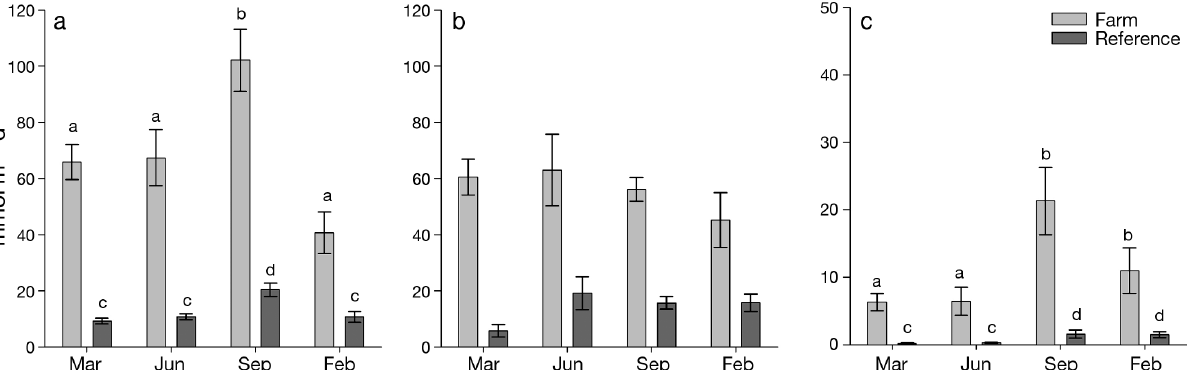
Fig. 3. Average (a) sediment oxygen consumption, and effluxes of (b) total CO 2 and (c) NH 4+ at the farming and reference loca- tion at 3 different time points over the production cycle. Superscripts denote significant differences across seasons and between sampling locations as defined by Tukeys HSD post hoc test at p < 0.01. Error bars represent SE (n = 6). Note the different y -axis